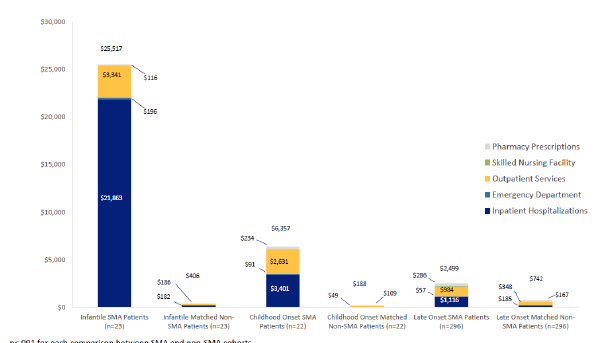
Figure 2. PFigure 2. Perer-Member-Member-P-Perer-Month Mean All-Cause-Month Mean All-Cause CCosts Betwosts Between SMA and Matched Non-SMA Peen SMA and Matched Non-SMA Patientsatients